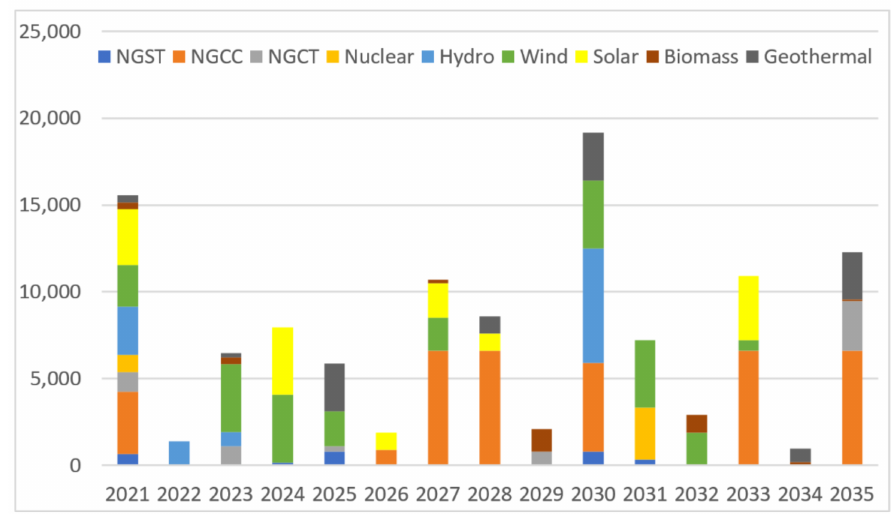
Figure 3. The capacity of additional units in each kind of power plant by the year from ISO view- point (MW). Table 5. Numbers of new units to be added during the planning horizon in TLBO algorithm.